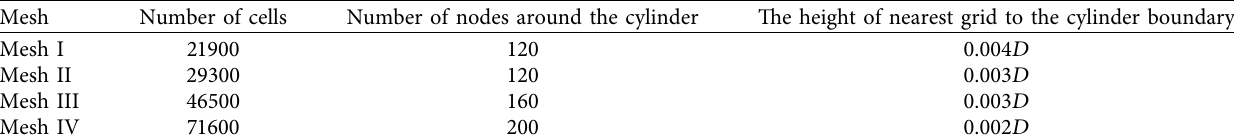
Table 2: The details of the mesh for the computation.